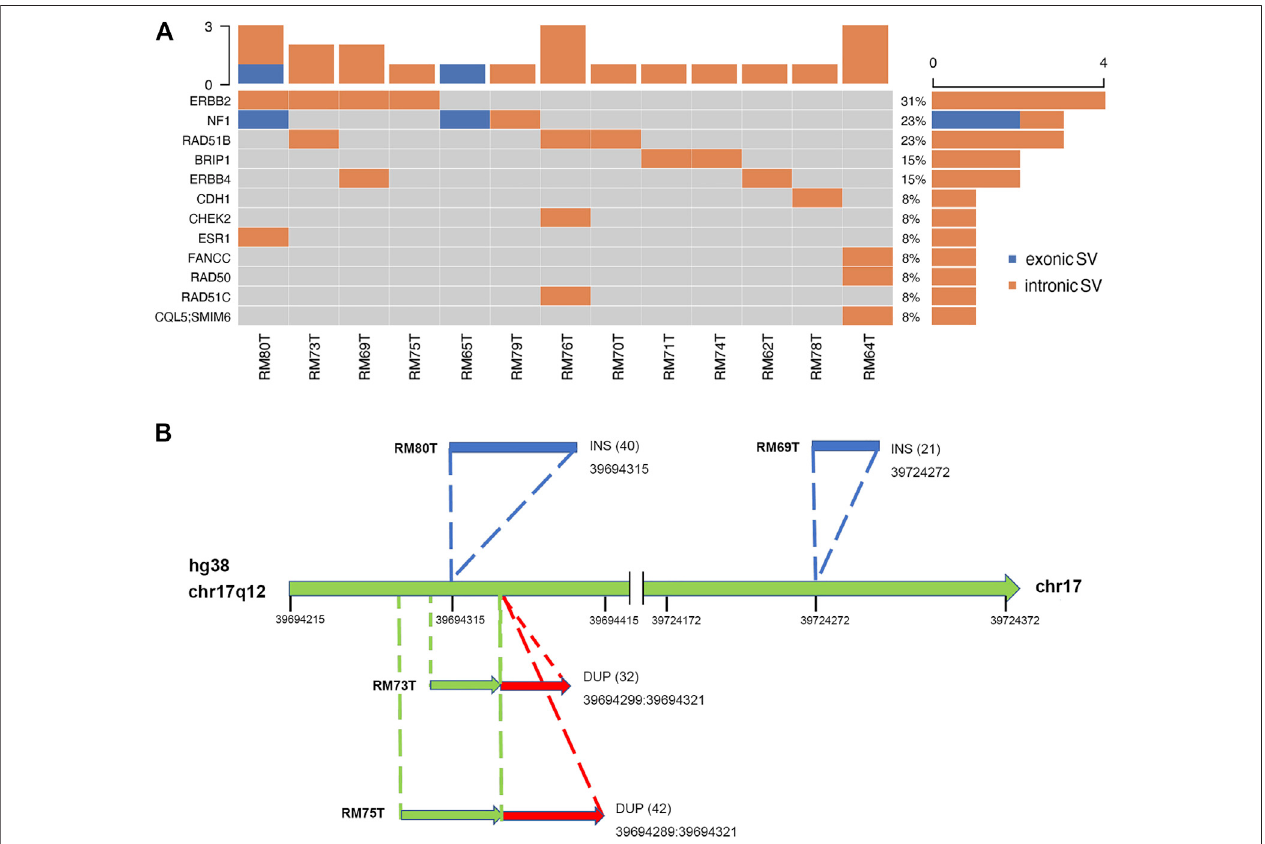
FIGURE 5 | Excessive somatic SVs in non-exonic region. (A) A summary of somatic SVs in particular genes and patients. Patients ’ tumor samples were examined against to their blood samples as control. SVs are sorted into exonic and intronic types based on their locations. Similarly, most SVs were found at non-exonic regions. Among thirteen patients, four of them had been identi fi ed to carry SVs at ERBB2. (B) Hotspot of SVs in ERBB2. There were two INS SVs (shown in blue) and two DUP SVs(red)foundinERBB2.NumbersinsideparenthesesindicatedthesizesofSVs.AconservedregionwithSVoccurrencewasexposedamongthreeindependent patients (RM80T, RM73T, and RM75T).